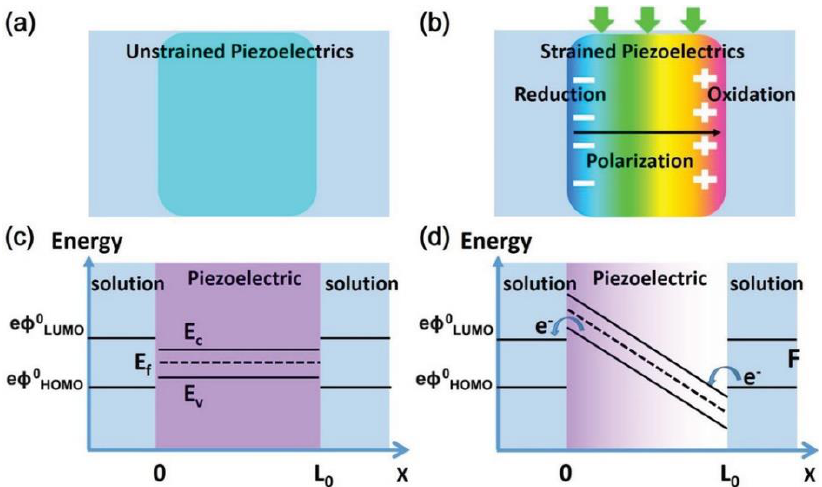
Figure 2. ( a , b ) Schematic diagrams show the formation of the piezoelectric field via band bending. ( c ) Band diagram of piezoelectric materials without ( c ) and with ( d ) strain force. Upon the band bending, the piezoelectric field changes the energy state across the material, allowing charge transfer at the material−solution interface. Reproduced with permission [20] . Copyright 2015, Elsevier Ltd.